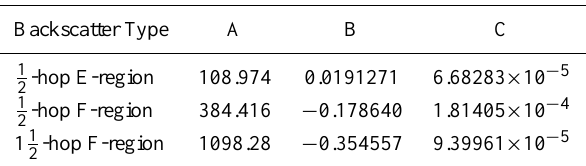
Table 1. The coefficients for Eq. (12) for the three different virtual height